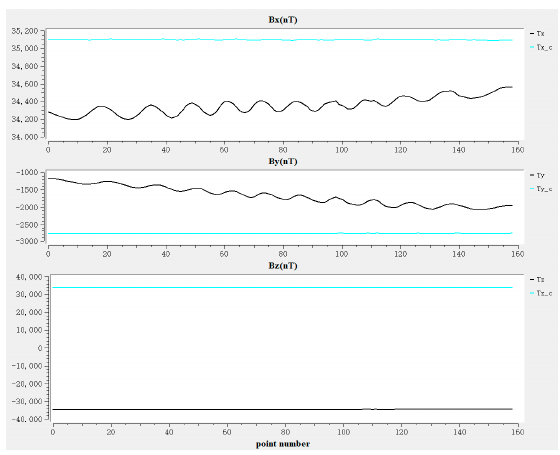
Figure 19. Real-time curve display on the upper computer.